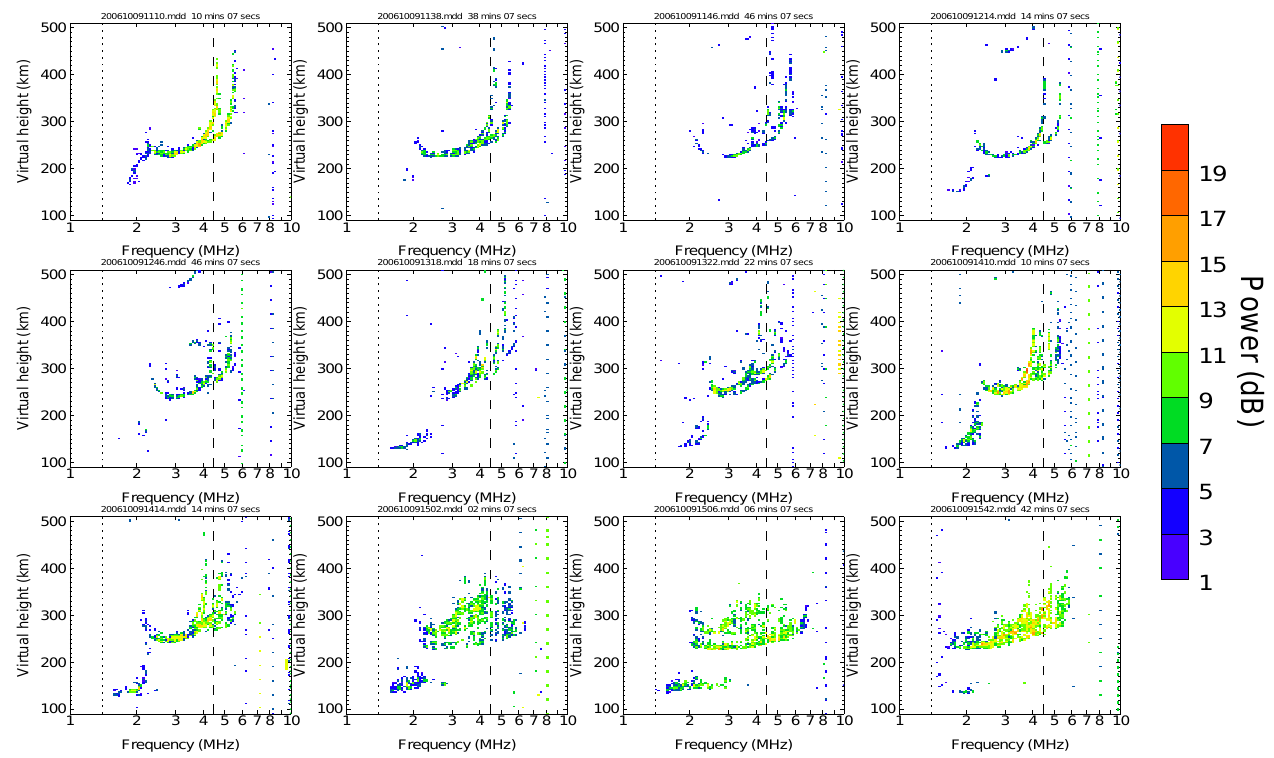
Fig. 2. A series of ionograms from 11:10 to 15:42UT on 9 October 2006 (interval 2). These ionograms show an ionosphere with an F-region that evolves over time, gradually becoming less structured and more